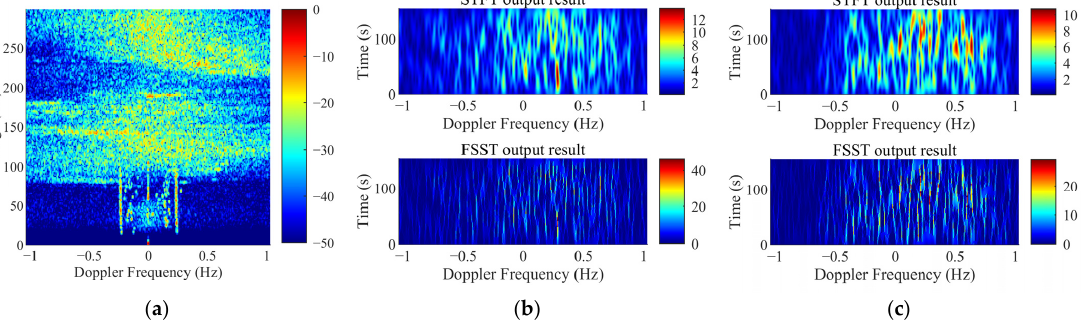
uneven clutter components in the TF plane around the ridge is markedly different from the targets.